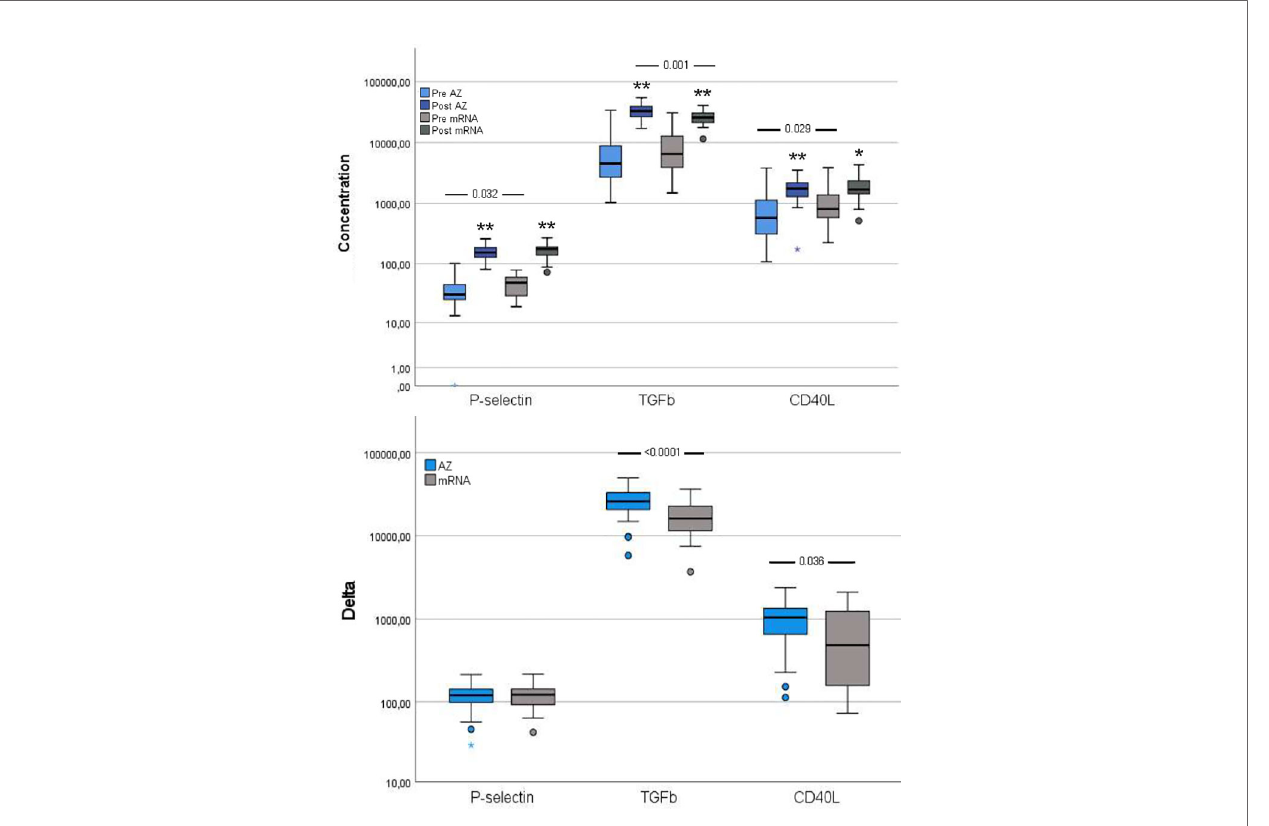
FIGURE 4 | Platelet activation markers pre- and post-vaccination and delta changes with either AZ (n=55) or mRNA (n=25) vaccines. Levels of platelet (P)-selectin (ng/ml), transforming growth factor (TGF)- b (pg/ml) and soluble CD40 ligand (CD40L, pg/ml) are displayed on a log scale. The top fi gure displays pre- and post- vaccination values, and the bottom fi gure displays delta changes. The box plots display median, fi rst and third quartile (box mid-line, button and top, respectively) and the whiskers display maximum and minimum values with outliers (circles) and extremes (small asterisks) displayed. AZ vaccinated individuals are displayed by blue bars (top fi gure: pre=light blue, post=dark blue) and mRNA vaccinated individuals are displayed by gray bars (top fi gure: pre=light gray, post=dark gray). Differences between AZ and mRNA vaccinated individuals either pre- and post-vaccination and delta changes are investigated by Mann-Whitney U test, with p- values displayed. Changes over time within the AZ or mRNA groups are investigated by Wilcoxon signed-rank test, with **p < 0.0001 and *p < 0.010 (displayed over the post-vaccination